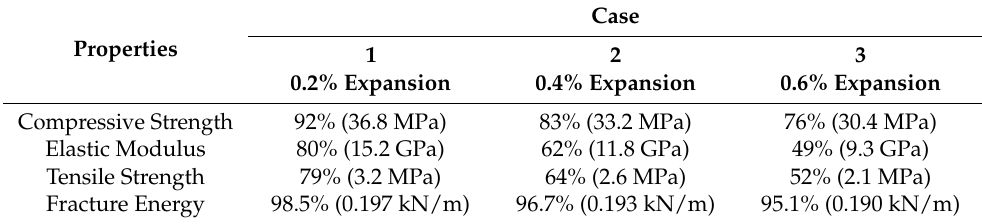
Table 9. Different cases of ASR and corresponding percentage remained in concrete mechanical properties.